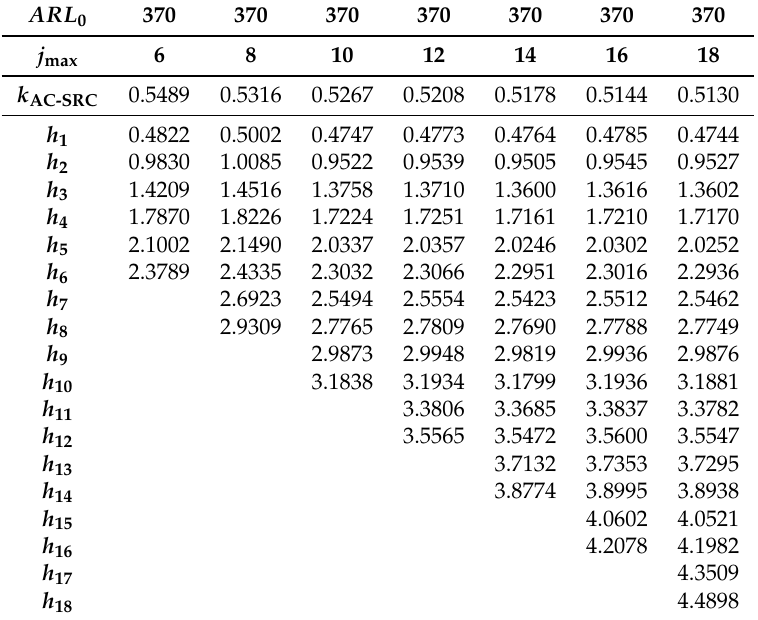
Table A4. AC-SRC for ARL 0 = 370.